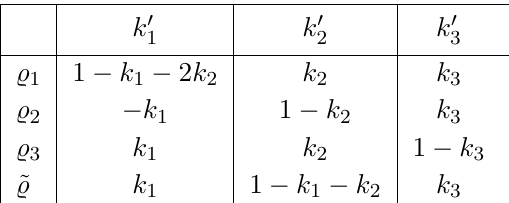
Table 1 . Symmetries of the Calogero-Sutherland model for generic values of the multiplicities. The last symmetry also involves a shift (cid:28) 0 = (cid:28) i (cid:6) i(cid:25) of the i